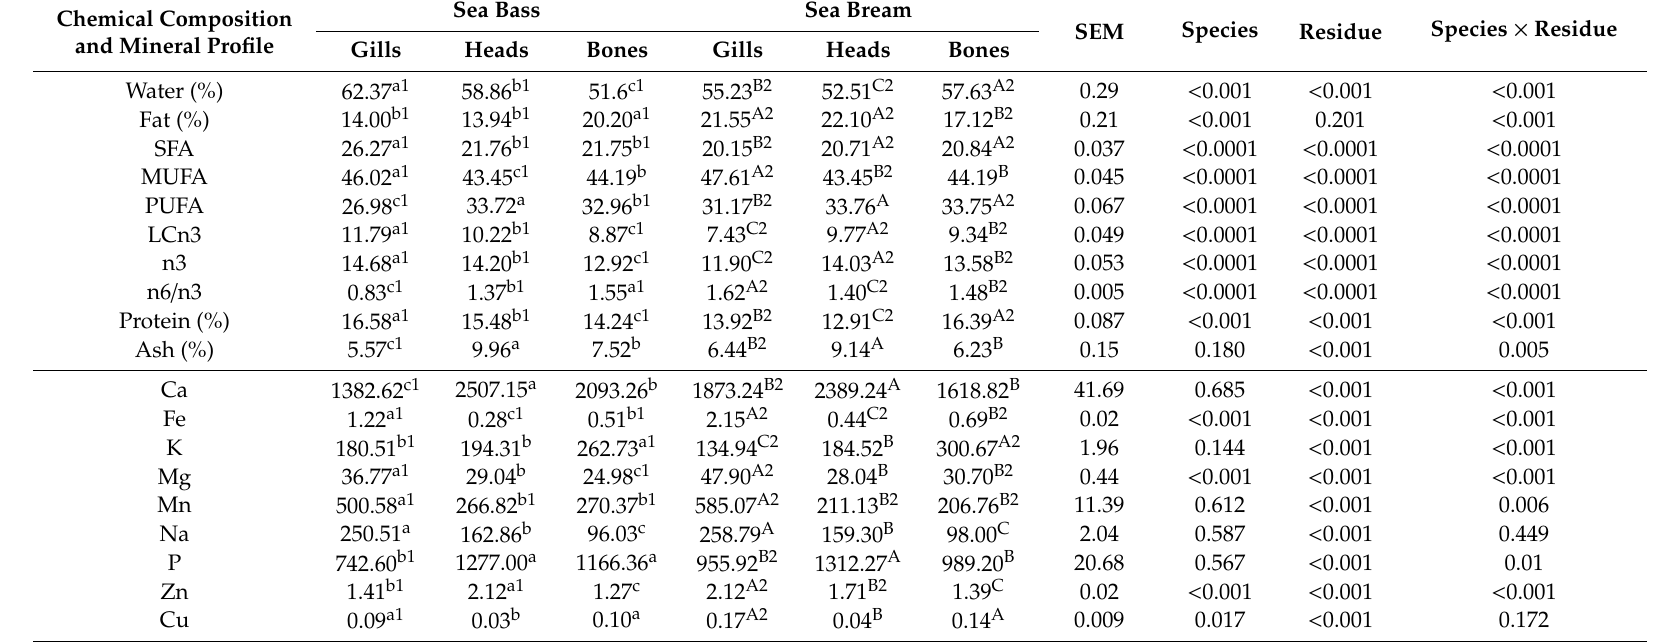
Table 1. Chemical composition and mineral profile of residues (gills, heads, and bones) from sea bass and sea